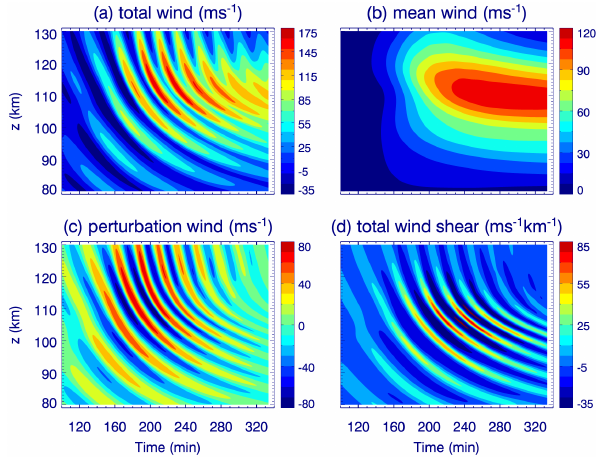
Figure 2. Time–height contours of the (a) total wind, (b) mean wind, (c) perturbation wind and (d) total wind shear located at the midpoint of the horizontal computation domain for the case EM (GW with λ z =